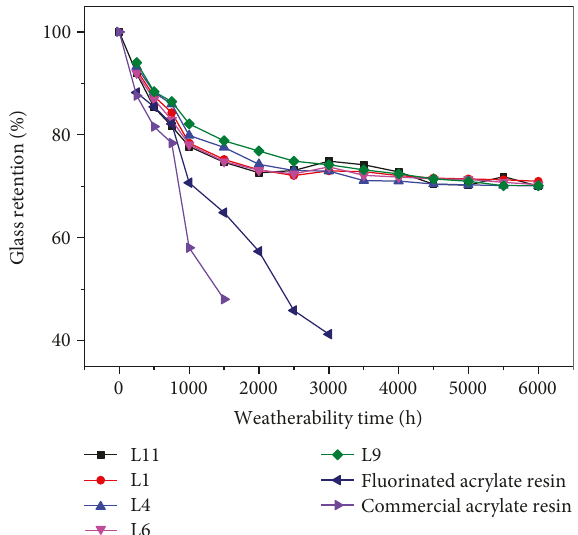
Figure 3: Accelerated weathering test of coatings with di ff erent polymers.